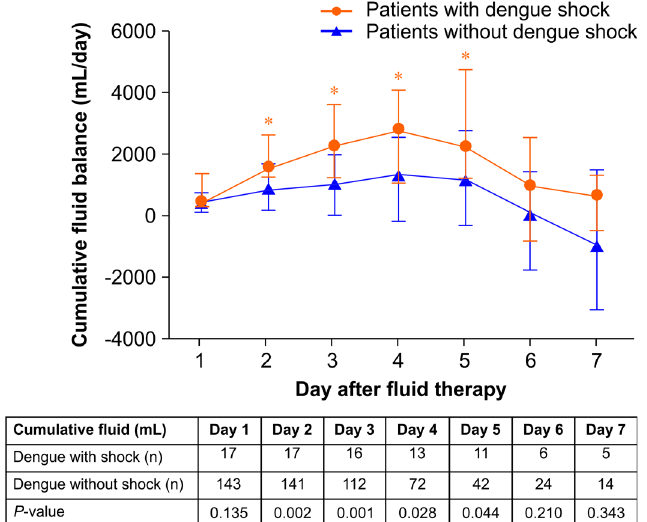
Fig 5. Daily cumulative fluid balance (mL) by day after fluid therapy among patients with and without dengue shock. (median [IQR]: 970.5 [678.0 – 7036.8] pg/mL vs. 141.0 [107.5 – 218.0] pg/mL, P < 0.001) and total number of B-lines (36 [21 – 81] scores vs. 3 [0 – 8] scores, P = 0.008) than those with hypo- volemic shock. After resuscitation, 3 (17.6%) patients had recurrent dengue shock caused by cardiogenic shock. The daily cumulative fluid balance was significantly higher among patients